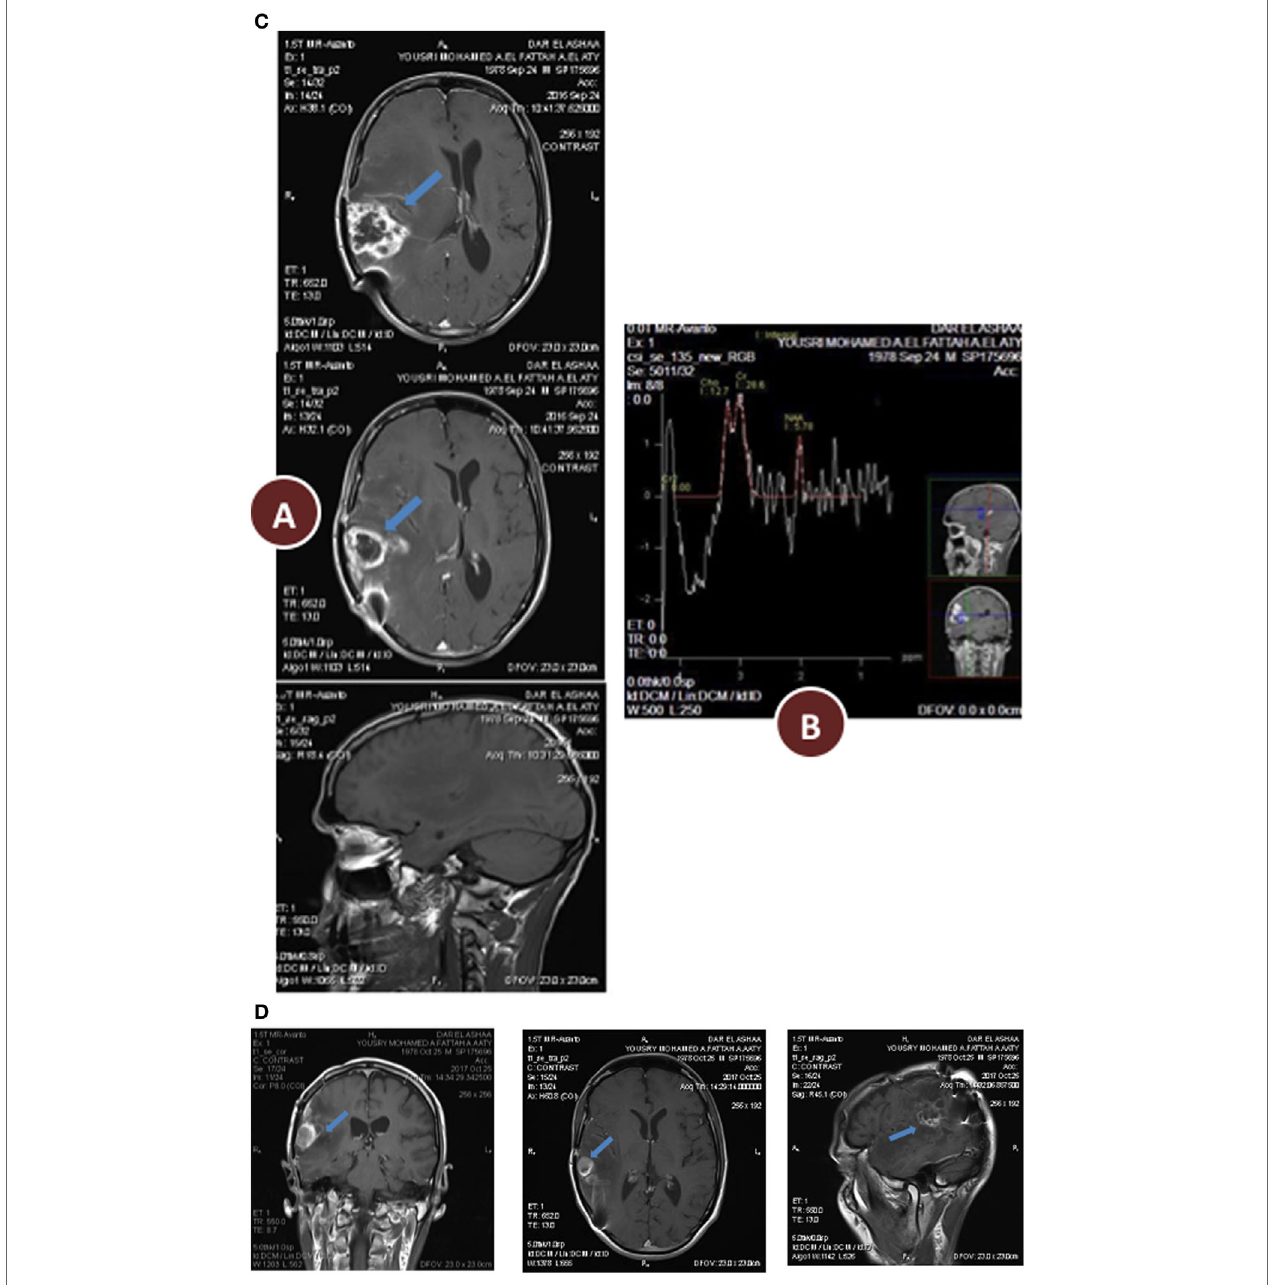
FiGURe 2 | (a) Preoperative radiology, (A) magnetic resonance imaging (MRI) contrast enhanced images axial and sagittal view revealed cystic lesion with perifocal edema “blue arrow” and midline shift “red arrow”; (B) magnetic resonance spectroscopy (MRS) of the lesion revealed high choline value (28) and low N-acetylaspartate (NAA) value (2.7); (C) Functional MRI showed affection of motor and sensory functions; (D) MRI tractography showed displaced motor and sensory fibers. (B) 3 months postoperative radiology (A) MRI contrast enhanced images axial and sagittal view revealed reduction in tumor size and perifocal edema with less midline shift; (B) MRS of the lesion revealed reduction of choline value (21) and elevation of NAA value (3.5) compare to preoperative study. (C) 12 months postoperative radiology (A) MRI contrast enhanced images axial and sagittal view revealed stationary or slightly decrease in tumor size and less perifocal edema with less midline shift; (B) MRS of the lesion revealed reduction of choline value (19) and elevation of NAA value (4) compare to previous study. (D) Postoperative radiology at 20 months. MRI contrast enhanced images for axial, sagittal, and coronal views revealed further reduction in tumor size, with no perifocal edema or midline shift.